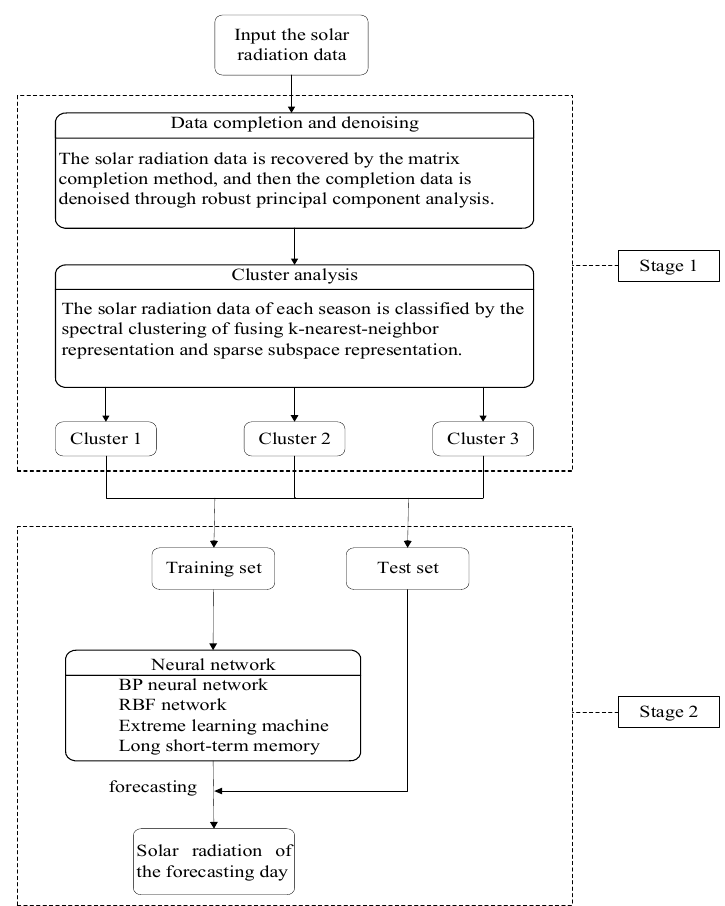
Figure 4. Framework of the hybrid solar radiation forecast model.